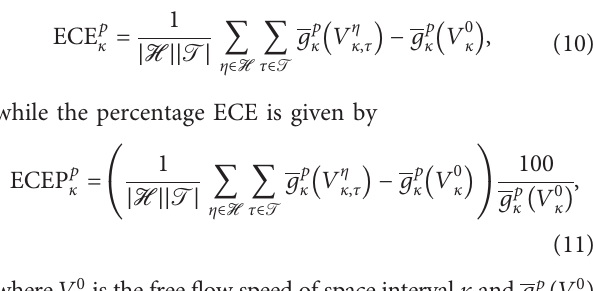
Figure 6: NO space-time field using the linearly interpolated x version of HBEFA, for the morning peak hours of a typical